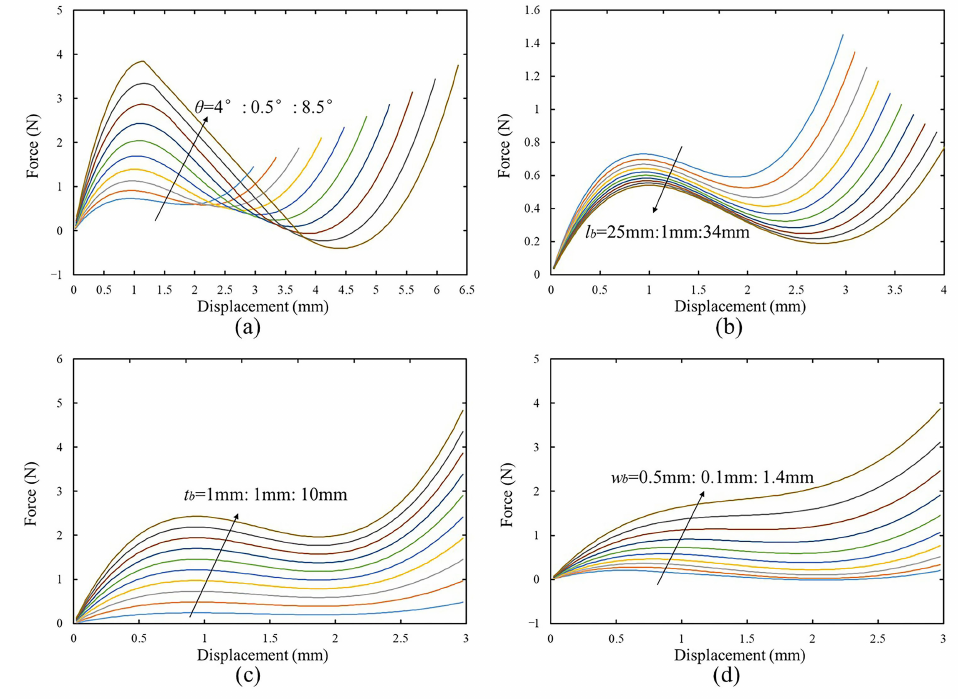
Figure 3. Simulation result of the force–displacement relationship for bistable beams with varying ( a ) inclination angle, ( b ) length, ( c ) thickness, and ( d )